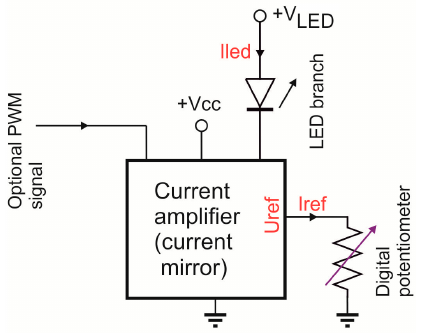
Figure 7. Single LED or LED branch driver.